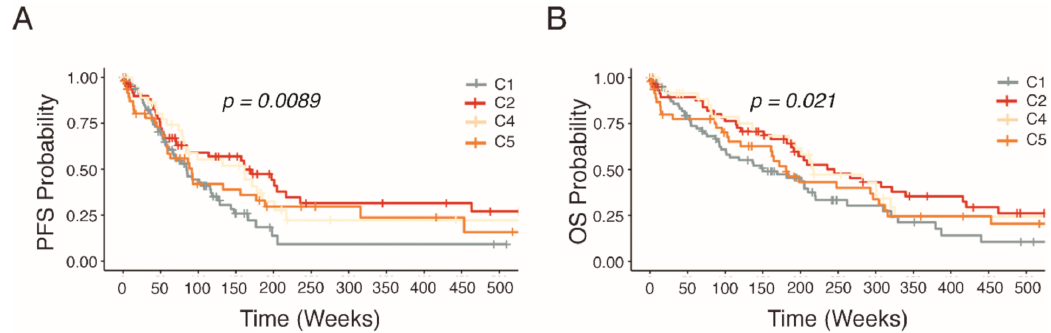
Figure 2. Kaplan–Meier estimated survival rates of HGSOC patients stratified into molecular subtypes by NanoString analysis. Non-parametric survival estimates of ( A ) progression free survival and ( B ) overall survival of HGSOC